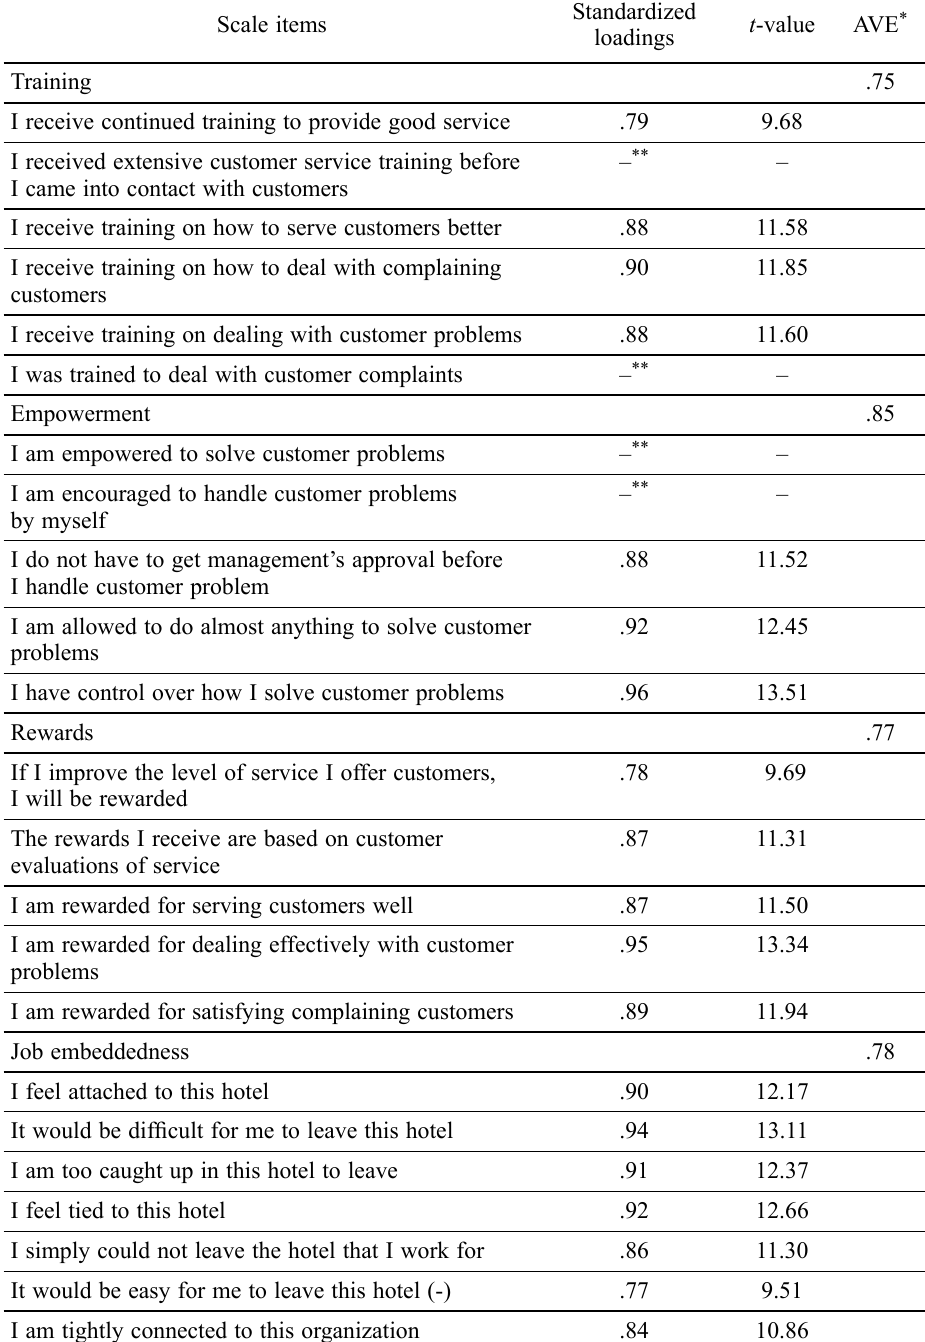
Table 1. Scale items and confirmatory factor analysis